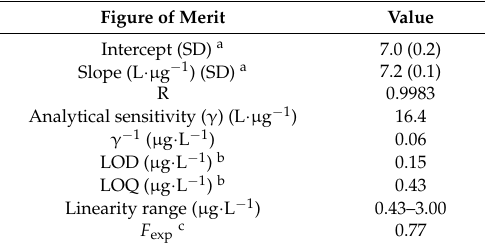
Table 1. Analytical figures of merit. Figure of Merit